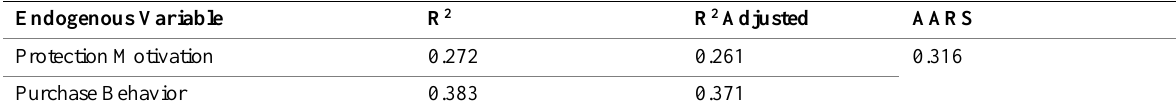
Table 5: R 2 and R 2